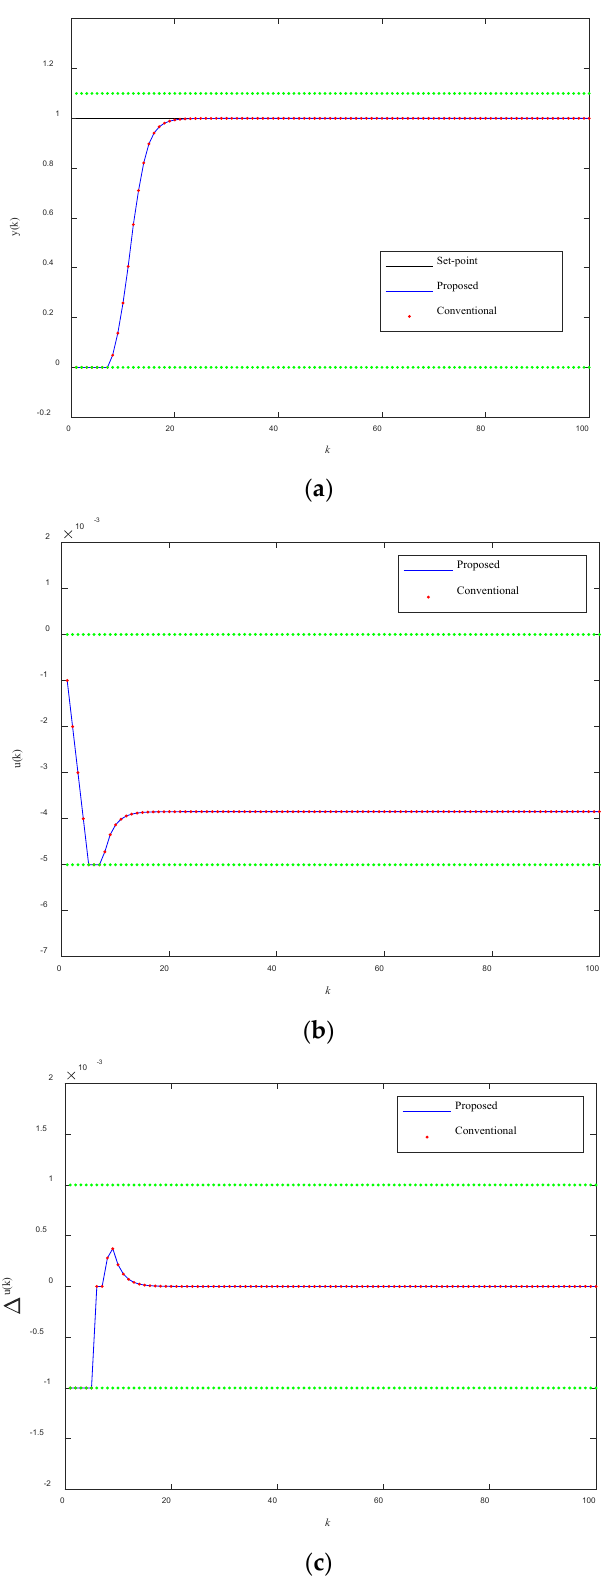
Figure 3. ( a ) Output responses under the model/plant matched case and loose constraints; ( b ) input responses under the model/plant matched case and loose constraints; ( c ) input increment responses under the model/plant matched case and loose constraints.